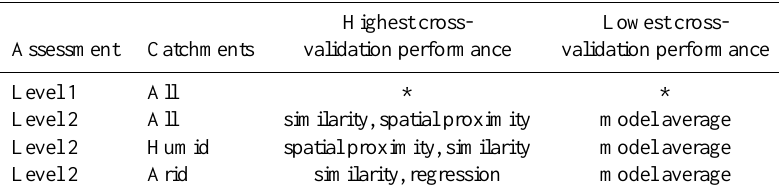
Table 3. Methods with the highest and lowest cross-validation performance of runoff predictions in ungauged basins. Arid relates to